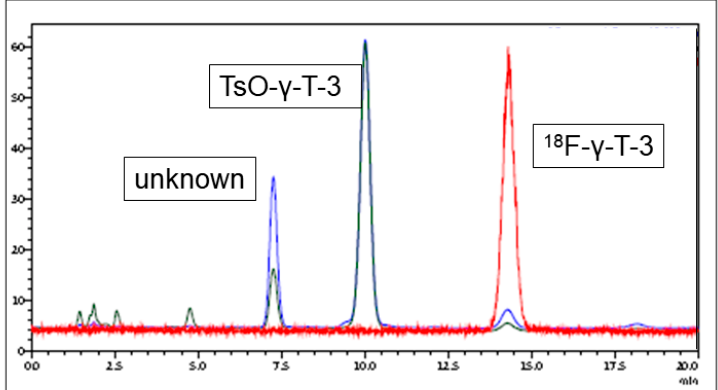
Figure 3. A representative HPLC radio-uv co-chromatogram of the reaction mixture after radiofluorination. The 291 and 254 nm peaks eluting at 14.4 min, and the radioactive peak (14.4 min; red trace) represent the co-mixture of authentic F- γ -T-3 (small blue peaks under the radioactive peak) and product [ 18 F]F- γ -T-3 in the reaction mixture. Absorption peaks in the blue trace (291 nm) correspond to the major UV absorption band of the methyl-substituted 6-chromanol (benzopyran) ring system (e.g., F- γ -T-3, TsO- γ -T-3), and the dark green trace (254 nm) is a less selective indicator of aryl compounds. The main UV absorption peaks eluting at 10.1 min (291 and 254 nm) represent unconsumed TsO- γ -T-3; the absorption peaks eluting at earlier times are unidentified. The isocratic reverse phase HPLC system is described in the text.